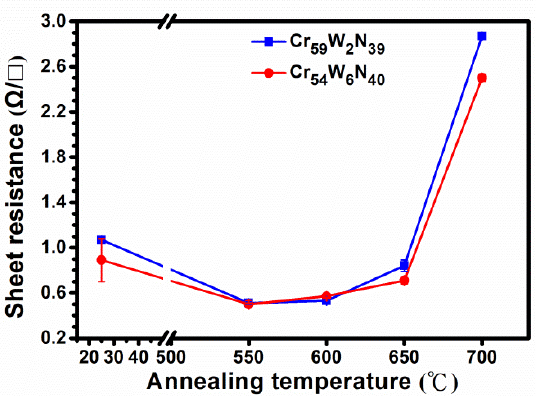
Figure 11. Sheet resistance of the annealed Cu/CrWN/Cr/Si samples.